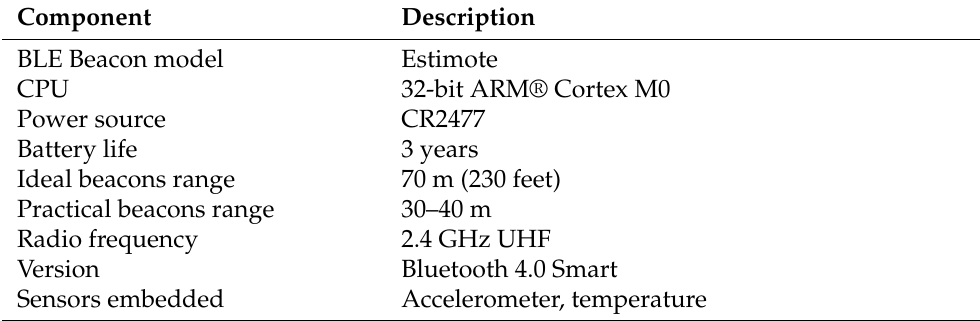
Table 4. Implementation